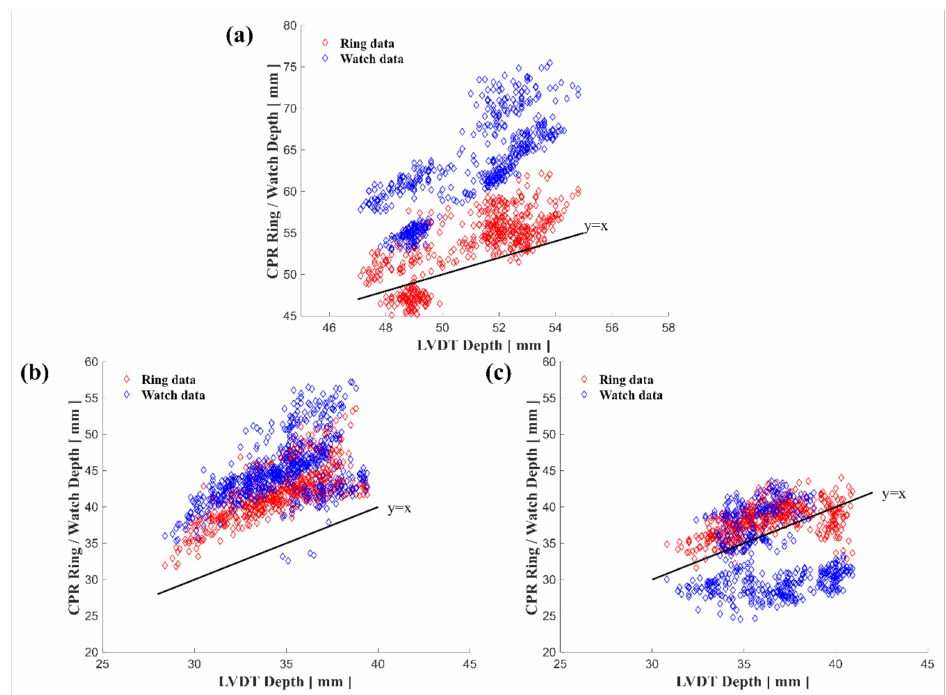
Figure 9. Comparison of mannequin LVDT depth and ring and watch depth. ( a ) Adult mannequin experiment. ( b ) Infant mannequin experiment using the two-finger method. ( c ) Infant mannequin experiment using the two-thumb method. Table 3. Absolute errors in two positions of compression